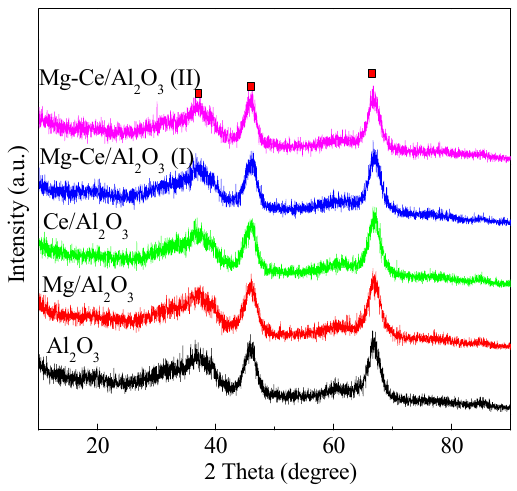
Figure 1. XRD patterns of Al 2 O 3 and metal oxide-loaded Al 2 O 3 catalysts.